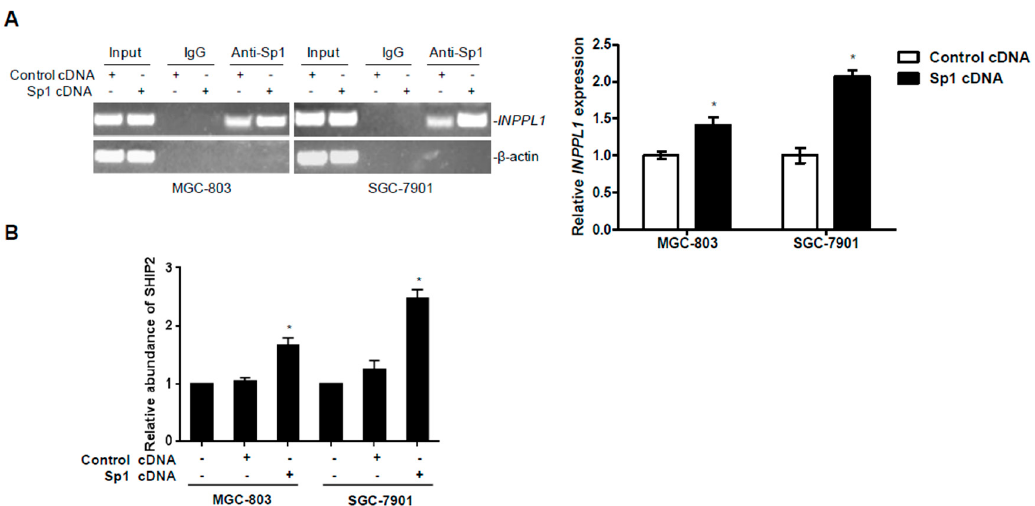
Figure 4. Overexpression of Sp1 enhances the transcriptional activity of SHIP2 promoter. ( A ) DNA fragments pulled down with Sp1 antibody from MGC-803 and SGC-7901 cells transfected with empty vector or an Sp1 construct were amplified by PCR. Data shown are representative of 3 individual experiments. Right column shows relative INPPL1 expression as shown in ( A ). Levels of INPPL1 in anti-Sp1 precipitates were normalized to those in the input. Quantitation of each band was determined using NIH Image J. The relative expression of INPPL1 in GC cells transfected with empty vector was arbitrarily designated as 1 ( n = 3, mean ± SEM, * p < 0.05 vs. empty vector); ( B ) mRNA expression levels of SHIP2 from MGC-803 and SGC-7901 cells transfected with empty vector or an Sp1 construct were analyzed by qRT-PCR. The relative abundance of SHIP2 mRNA expression in parental GC cells was arbitrarily designated as 1 ( n = 3, mean ± SEM, * p < 0.05 vs. empty vector).